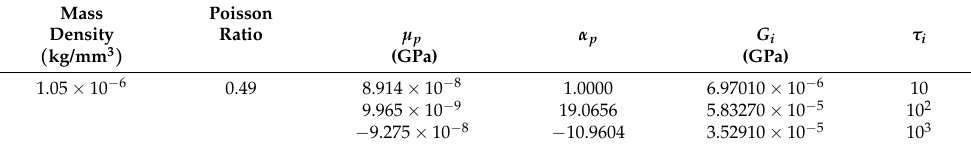
Table 1. Material properties of the lumped abdominal tissue (flesh) and the ribs. Flesh ine Mass Bulk Damping Shear Density Modulus Coefficient Modulus ( kg/mm 3 ) (GPa) (GPa) 1.06 × 10 − 6 2 0.40 4.00 × 10 − 5 Ribs Mass Young’s Poisson Yield Tangent Density Modulus Ratio Stress Modulus ( kg/mm 3 ) (GPa) (GPa) Table 2. Material properties of the liver tissue. Mass Poisson Density Ratio µ p α p G i τ i ( kg/mm 3 )